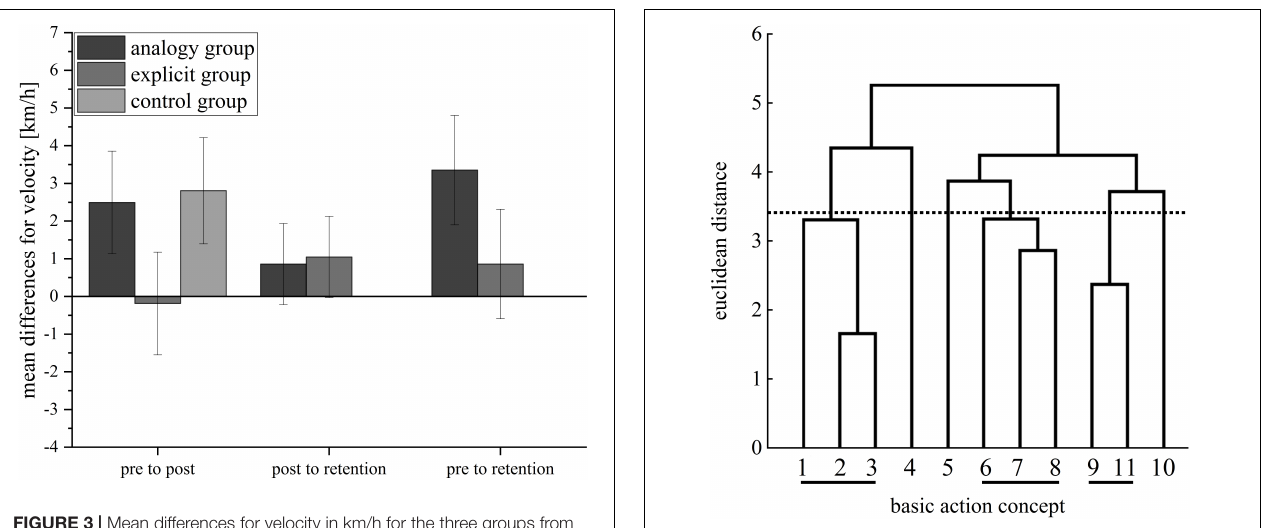
FIGURE 4 | Mean group dendrogram of the analogy group’s ( n = 15) tennis serves on the pretest. The numbers on the x -axis represent the BACs; the numbers on the y -axis represent Euclidean distances. The lower the link between the BACs was, the shorter the Euclidean distance. The horizontal dotted line marks d crit for a given α -level ( d crit = 3.41; α = 0.05): Links between the BACs above the line are considered unrelated; BACs (1) ball throw, (2) forward movement of pelvis, (3) bending the knees, (4) bending the elbow, (5) frontal upper body rotation, (6) racket acceleration, (7) whole body